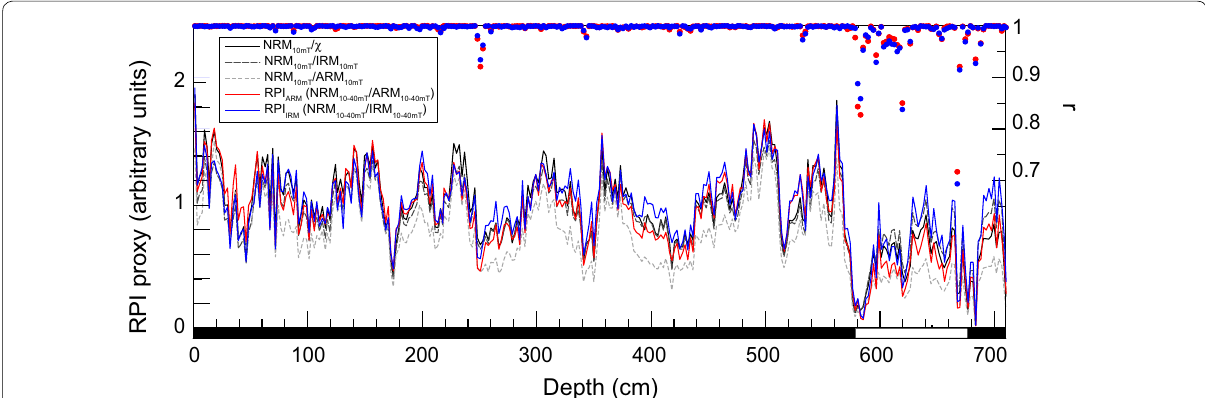
Fig. 6 Relative paleointensity proxies for NPGP1401-2A. Correlation coefficient ( r ) values for the slope of RPI ARM ( RPI IRM ( NRM 10–40mT /IRM 10–40mT ) are displayed at the top of the panel as red dots and blue dots, =